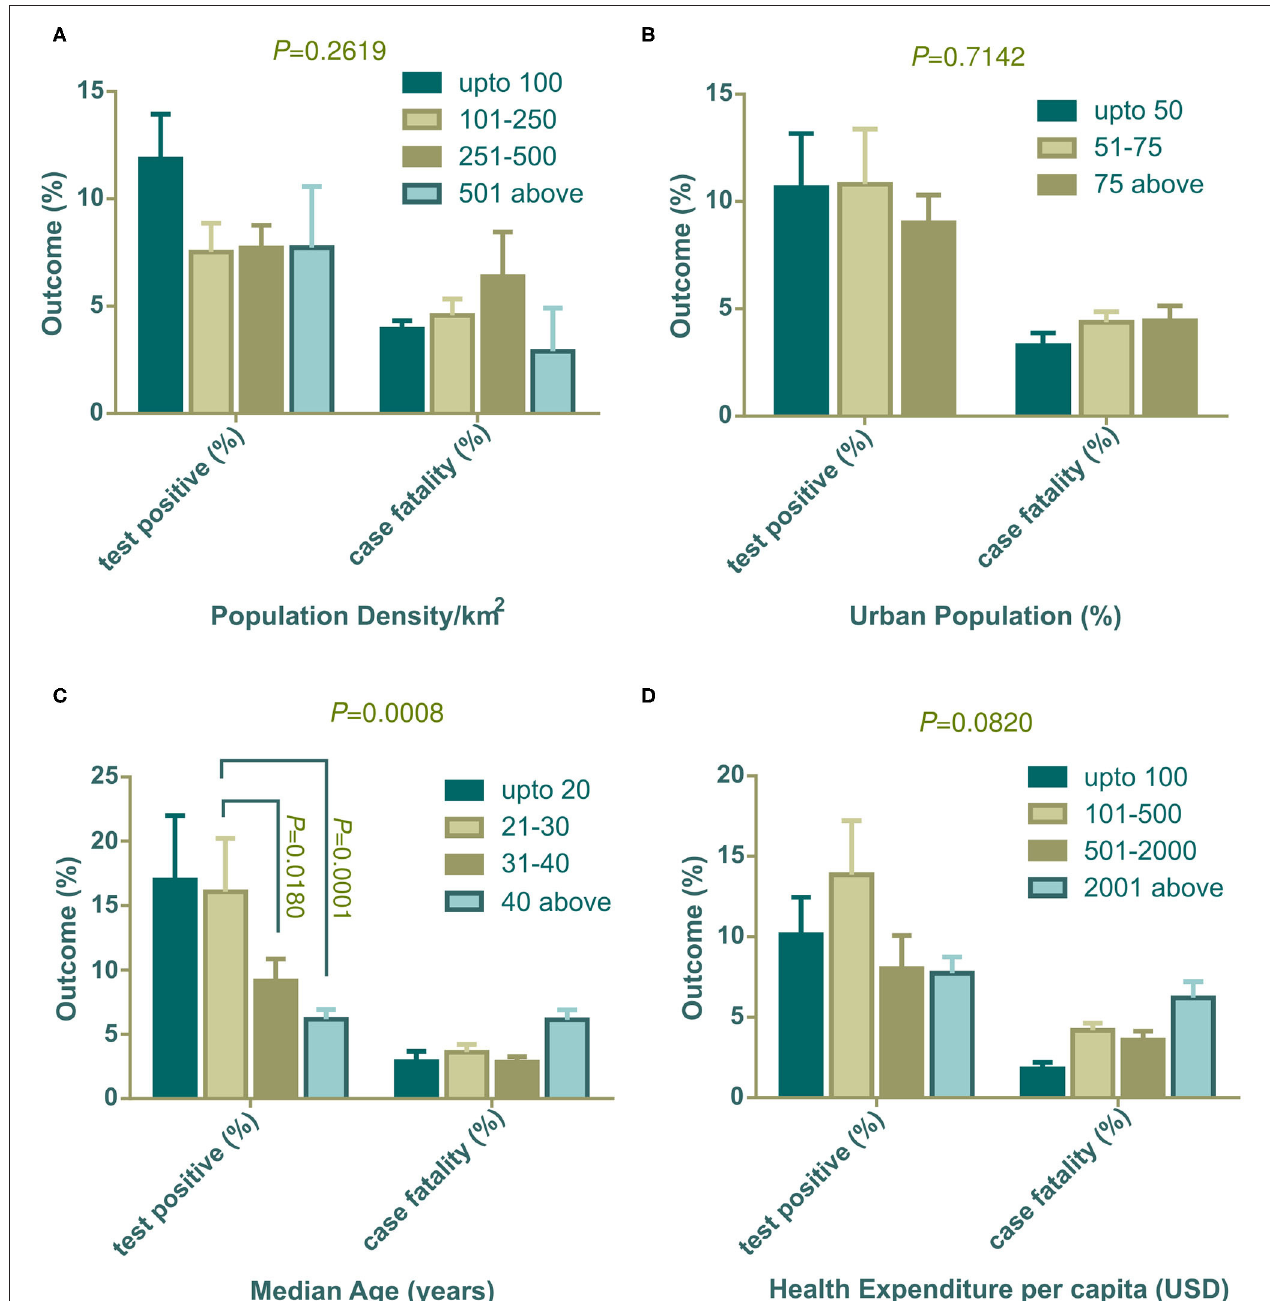
FIGURE 1 | Positive tests (%) and case fatality (%) distribution among countries categorized with population density (A) , urban population (B) , median age (C) , and health expenditure per capita (D) . All outcomes (%) are presented as mean ± SEM. In (C) , mean positive test (%) of countries with 21–30 years of median age is statistically significant against 31–40 years of median age ( P = 0.0180) and median age over 40 years ( P = 0.0001) by Tukey’s multiple comparison test. Two-way ANOVA interaction P- value are shown on top of each graph. Statistically significant interaction P- value indicates that change in independent variable interacts differently on two dependent outcomes.